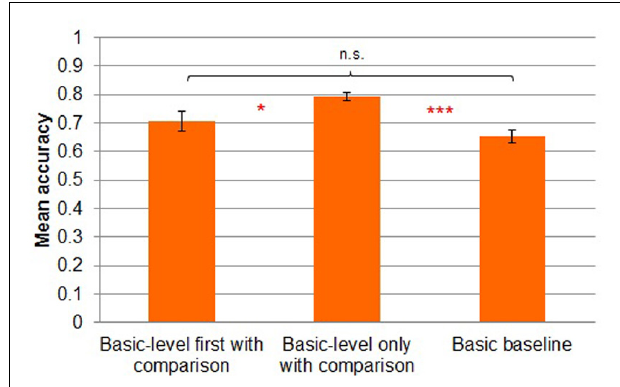
FIGURE 7 | Mean accuracy by transfer condition in Experiment 2. Error bars represent SEs. * p < 0.05, *** p <